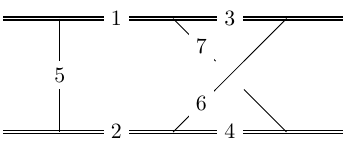
Figure 11. Propagators for the IX